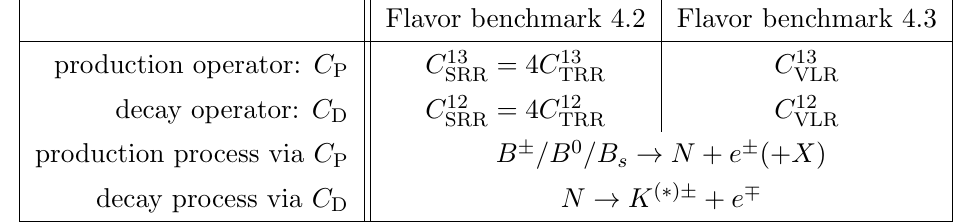
Table 6 . Summary of (cid:13)avor benchmark